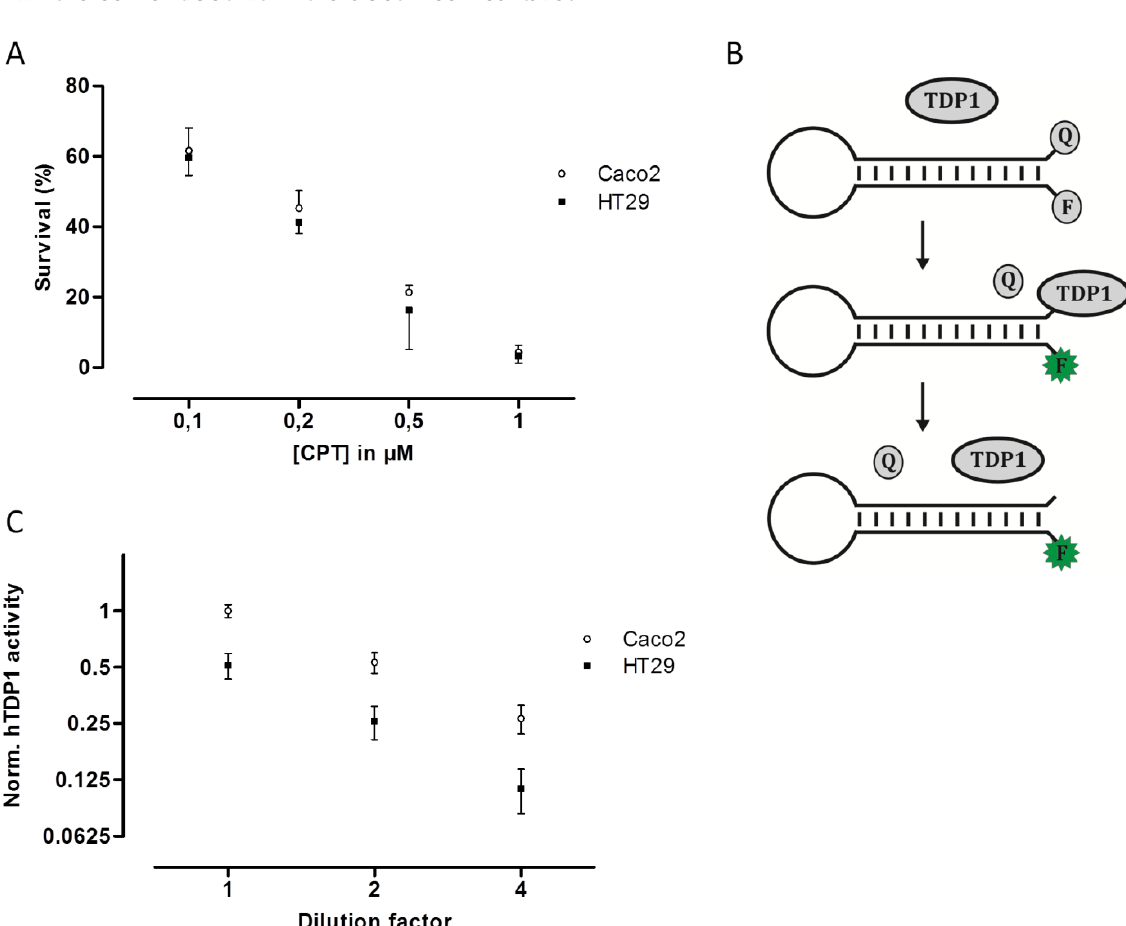
Figure 2. ( A ) Survival assay of Caco2 and HT29 cells in the presence of CPT. Caco2 and HT29 cells were incubated with 0.1, 0.2, 0.5, 1 µM of CPT for 24 hours before the percentage of viable cells was estimated using the trypan blue exclusion method. All data are presented as the percentage of live cells with mean ±SD from triplicate experiments. ( B ) Graphic depiction of the TDP1 assay. The TDP1-biosensor is designed to adopt a beacon structure, bringing the quencher (Q) and fluorophore (F) in proximity thus quenching the emission from the fluorophore. In presence of active TDP1, the quencher is removed from the TDP1-biosensor, and the emission of the fluorophore becomes quantifiable. ( C ) TDP1 activity measurement in 1x, 2x, and 4x dilution of whole cell extract of Caco2 and HT29, depicted as mean ±SD in a log2 XY-plot. The data were collected from triplicate reactions and normalized to the mean TDP1 activity in undiluted whole cell extract from the Caco2 cell